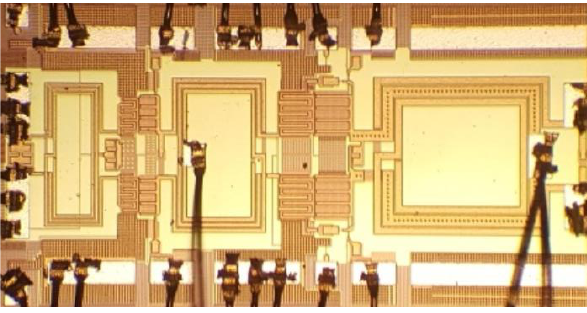
Figure 15. Photograph of the designed CMOS PA.